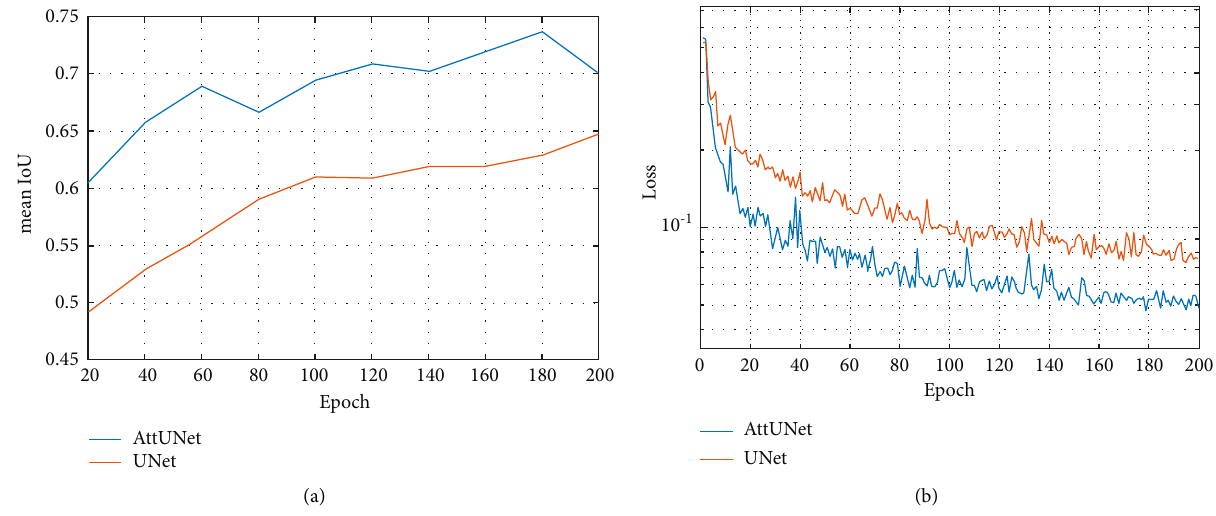
Figure 7: Mean IoU and loss curve during training with 200 epoch.